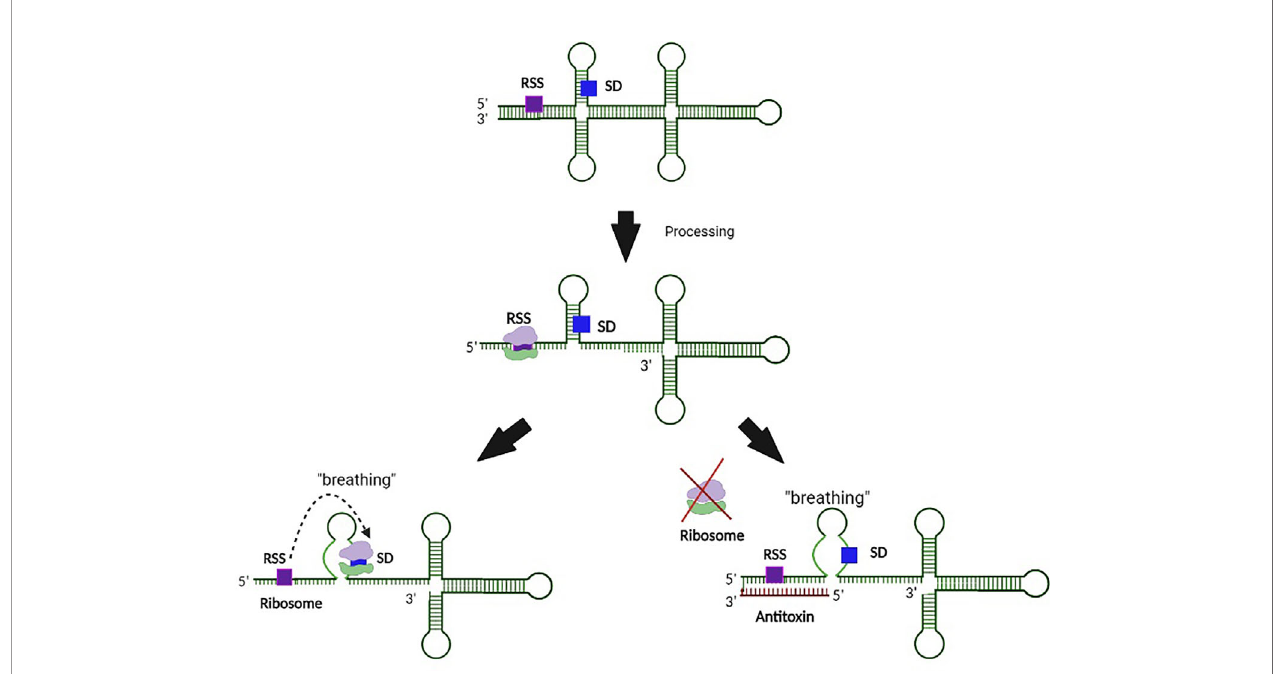
FIGURE 3 | Regulation of Type I toxin production by binding of the antitoxin to an associated ribosomal standby site. In this example, processing of the toxin transcript exposes a ribosomal standby site (RSS) that facilitates binding of the ribosome to the SD site. Interaction between the antitoxin and RSS on the toxin transcript prevents ribosomal binding to this site, and thus subsequent binding to the SD. Such regulation prevents translation of the Type I